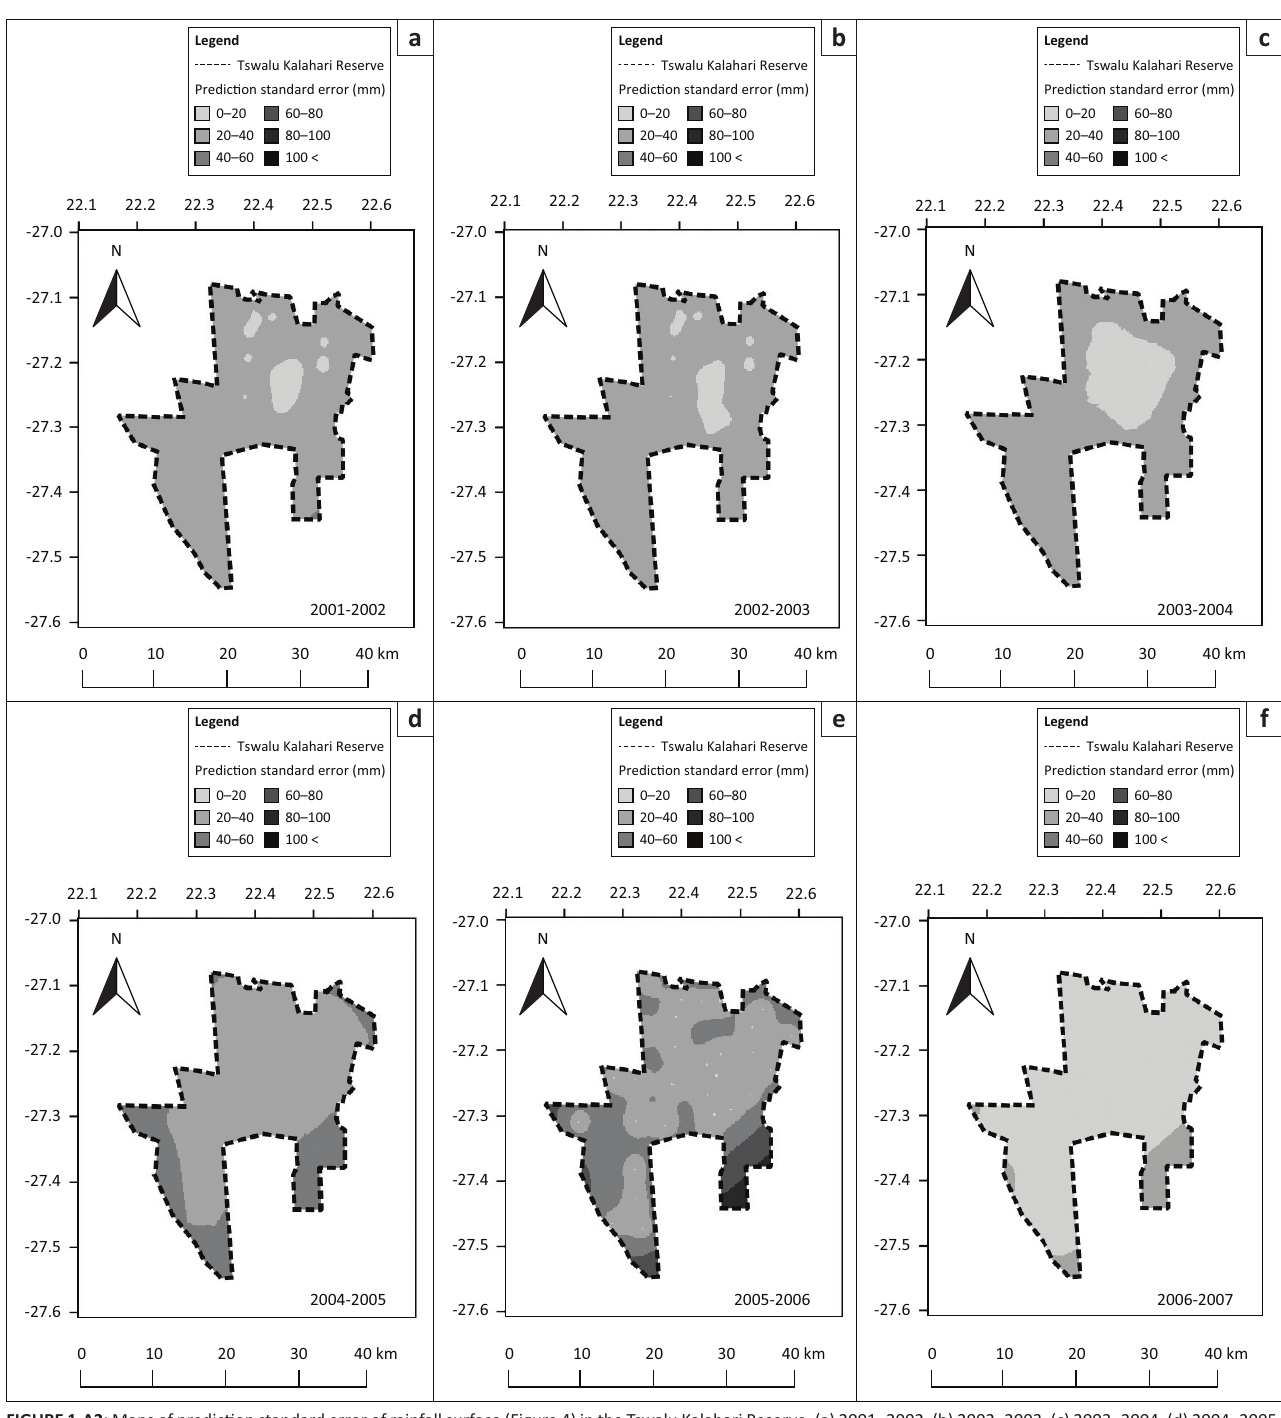
FIGURE 1-A2: Maps of prediction standard error of rainfall surface (Figure 4) in the Tswalu Kalahari Reserve. (a) 2001–2002, (b) 2002–2003, (c) 2003–2004, (d) 2004–2005, (e) 2005–2006, (f) 2006–2007, (g) 2007–2008, (h) 2008–2009, (i) 2009–2010, (j) 2010–2011, (k) 2011–2012, (l) 2012–2013 and (m) 2013–2014.